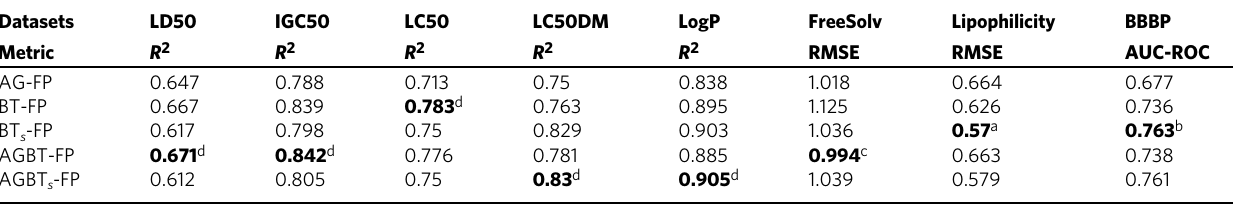
Table 2 Performance of descriptors generated with the AGBT framework on eight datasets.